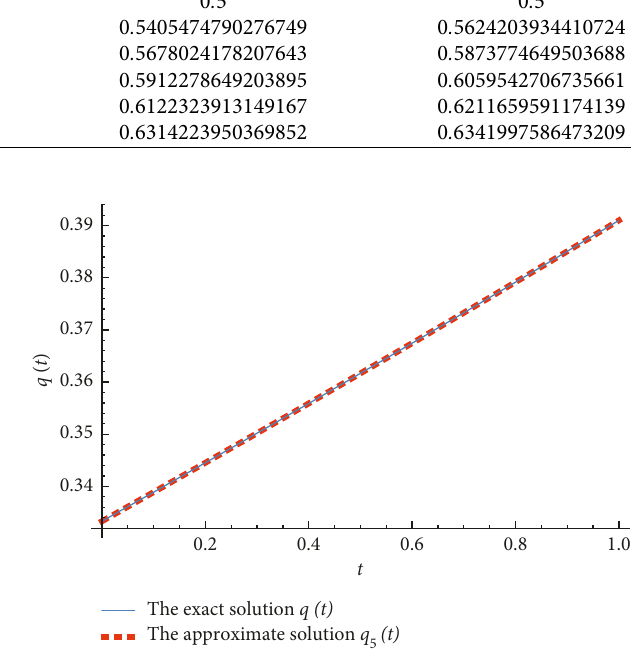
Figure 3: The behavior of FRPS solution at α � 1 for Example